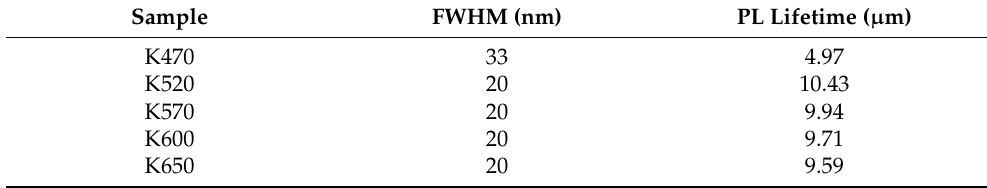
Figure 17. Room-temperature PL spectra of samples K470, K520. K570, K600 and K650. The broad shape for sample K470 indicates it has a different host from others. Table 6. PL lifetime and FWHM of samples K470, K520, K570, K600 and